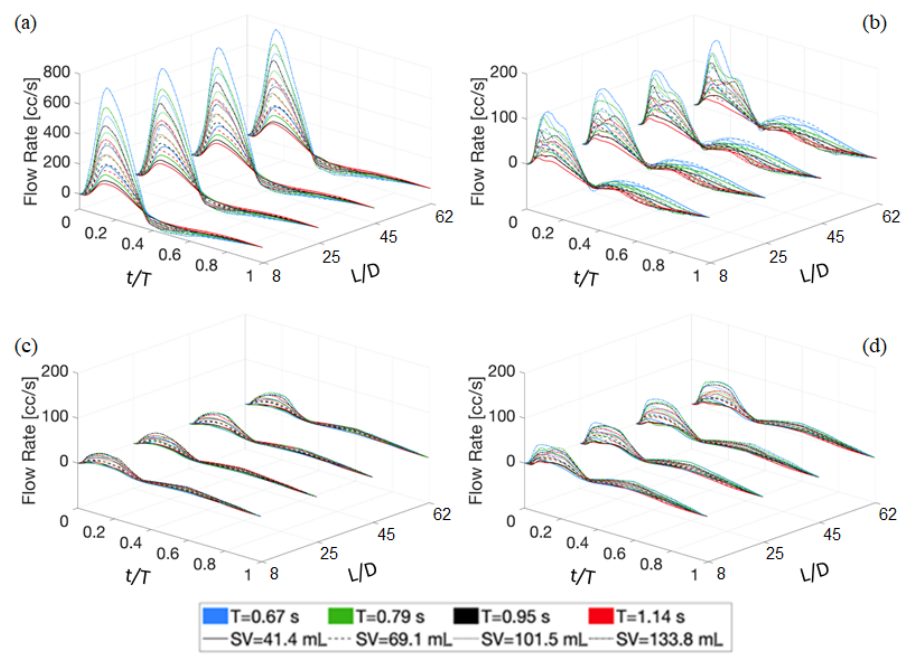
Figure 10. Effect of SV , T , and L / D on the deterministic waveforms of the flow rate at the four outlets of the aneurysmatic aorta: ( a ) DA, ( b ) BCA, ( c ) LCCA, and ( d ) LSA.